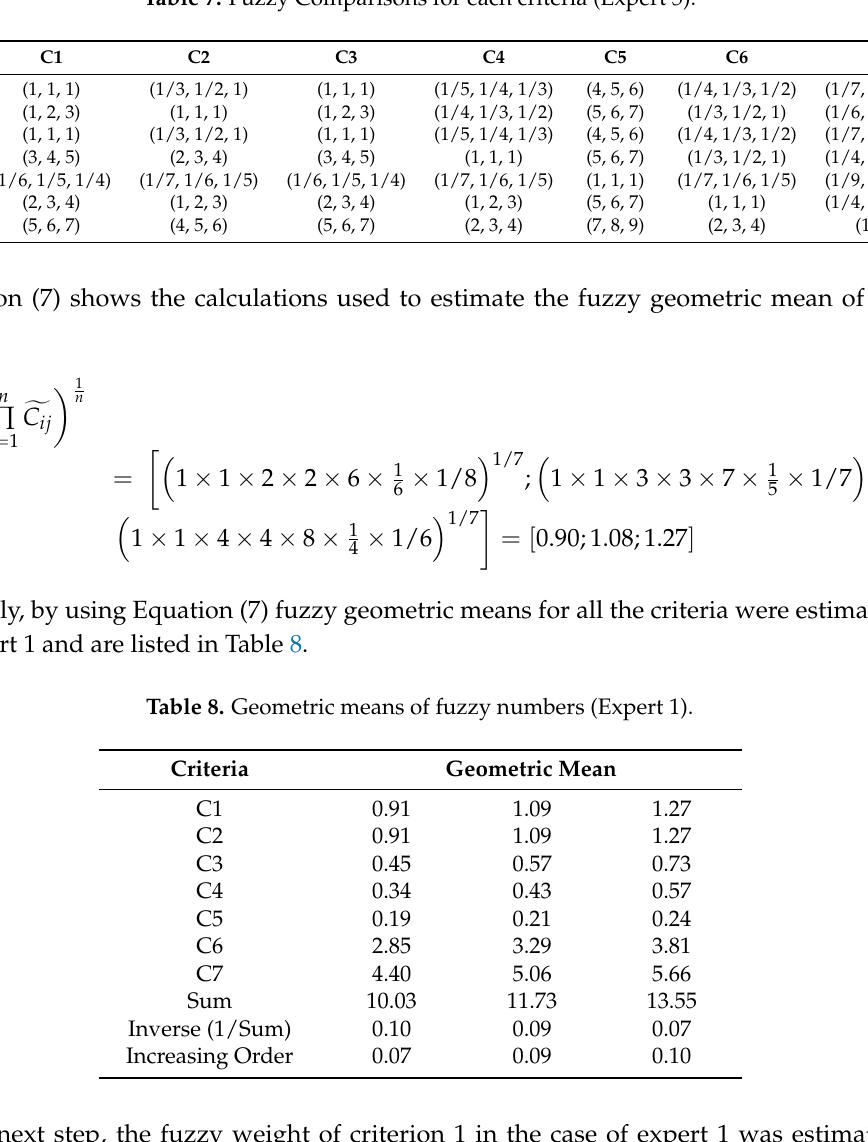
Table 7. Fuzzy Comparisons for each criteria (Expert 5).